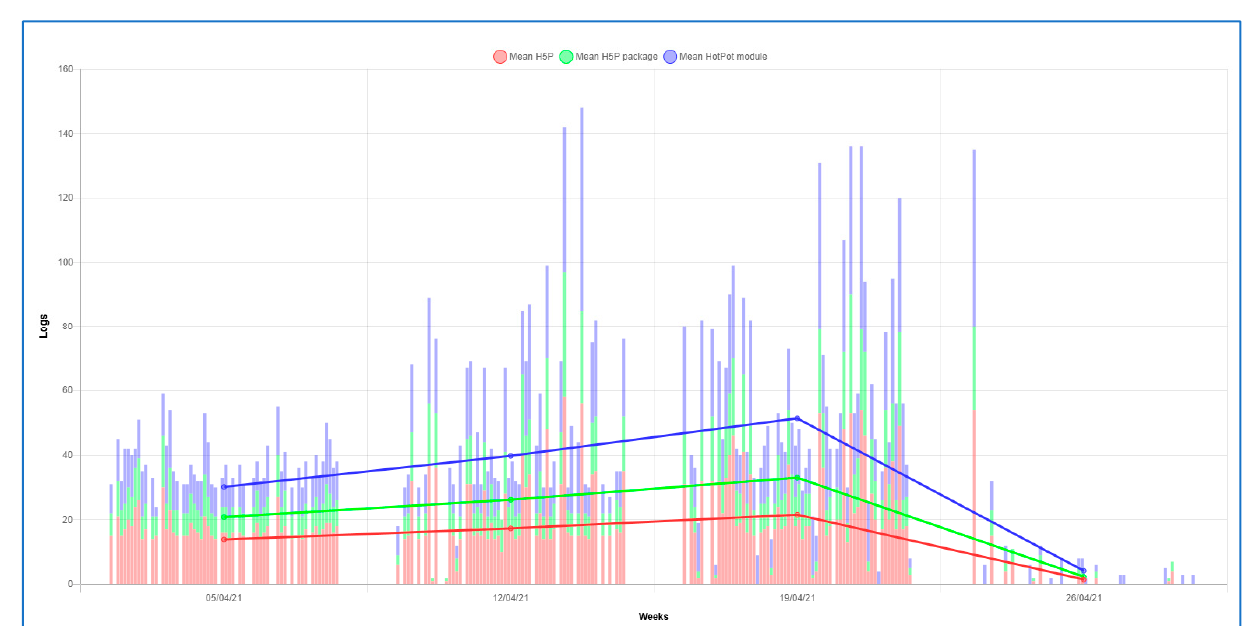
Figure 2. Stacked bar of the interaction records of the occupational therapy students in the DGBL activities.